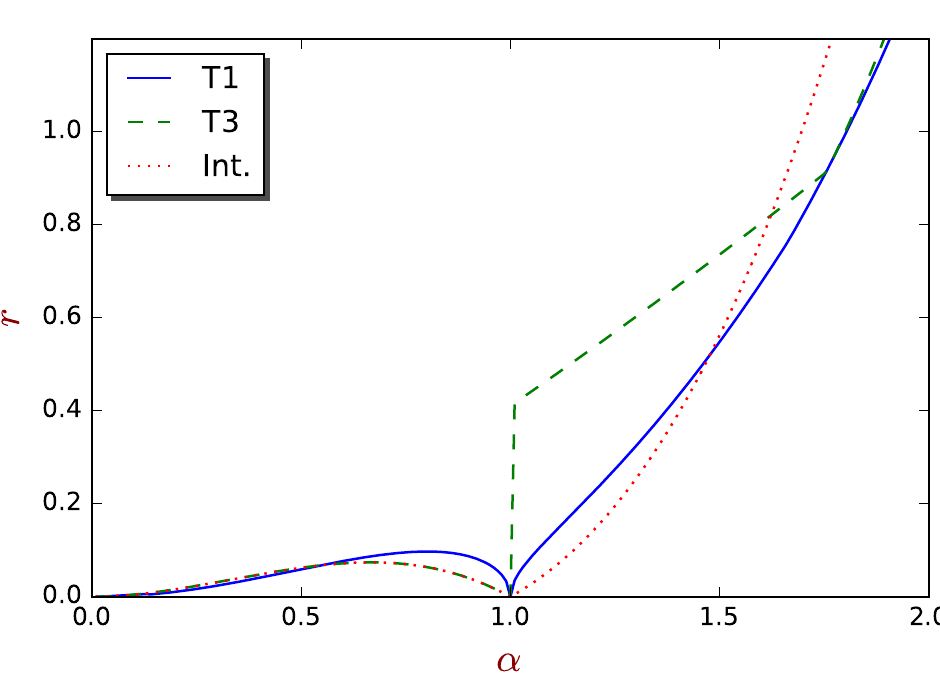
Fig. 2 Spectral radius of the AM2 methods for T1, T3 and interpolation techniques